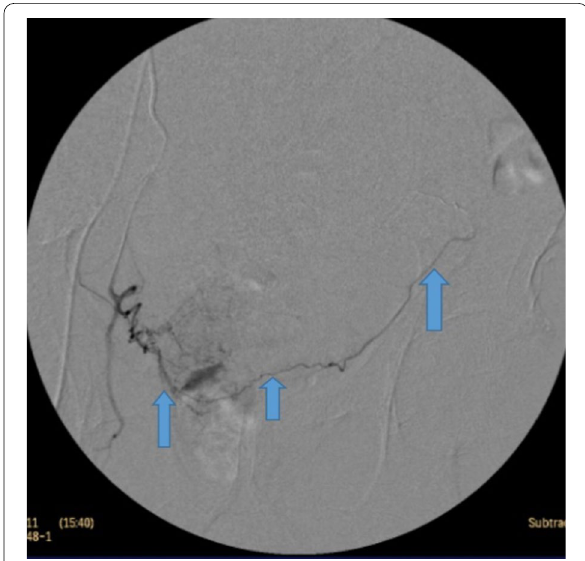
Fig. 13 Angiography image showing right‑side anastomosis with the other pelvic side (blue arrows)